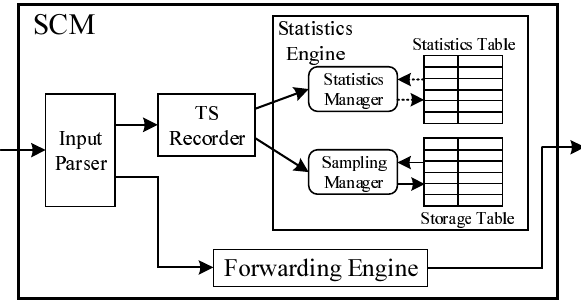
Figure 3. The design of Statistics Collection